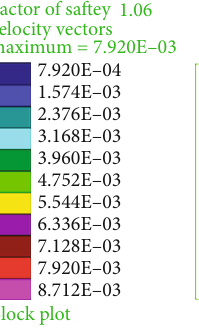
Figure 6: FOS and the failure state of velocity vectors.